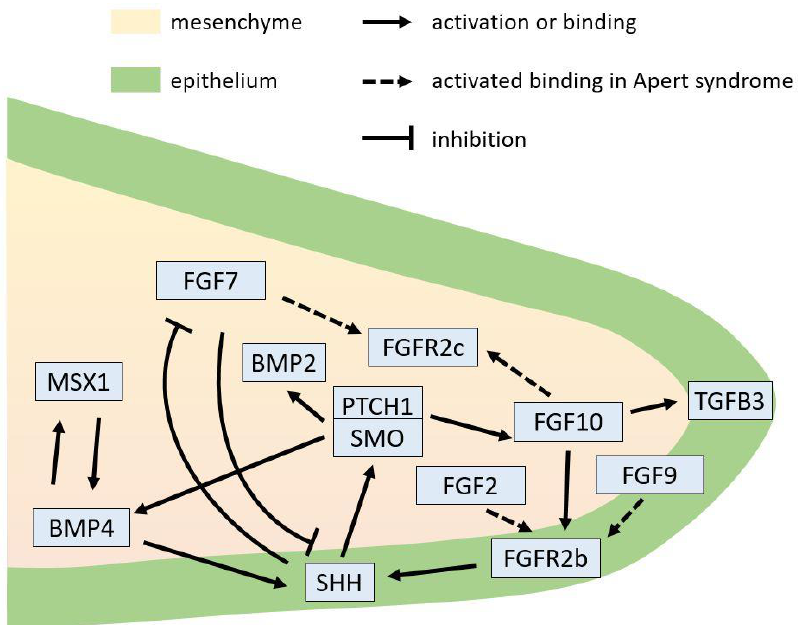
Figure 3. Potential signaling regulations involved in palatal defects in Apert syndrome during pal- atal shelf